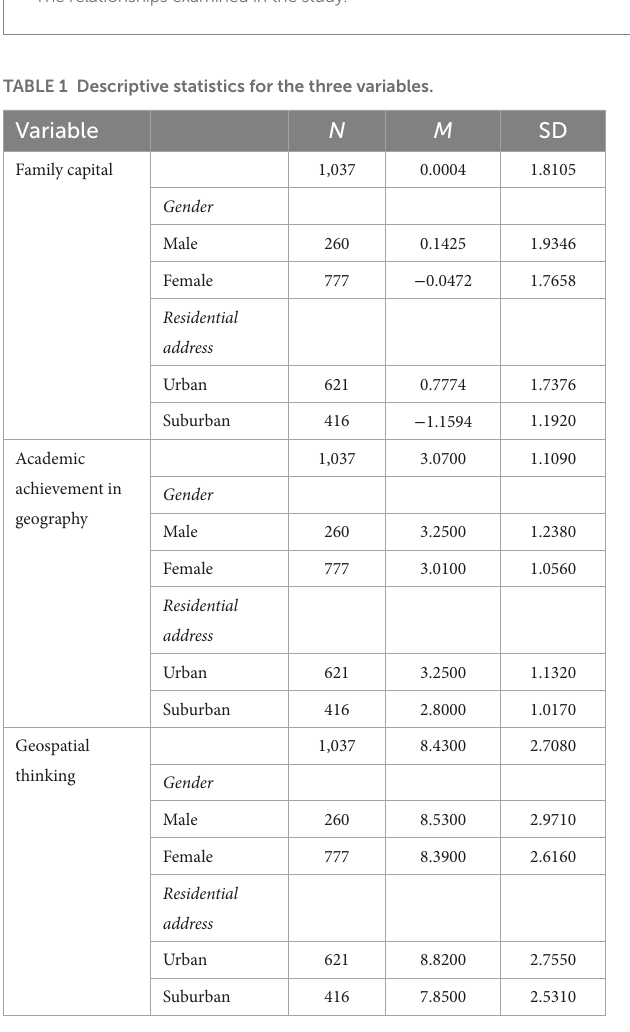
FIGURE 1 The relationships examined in the study.